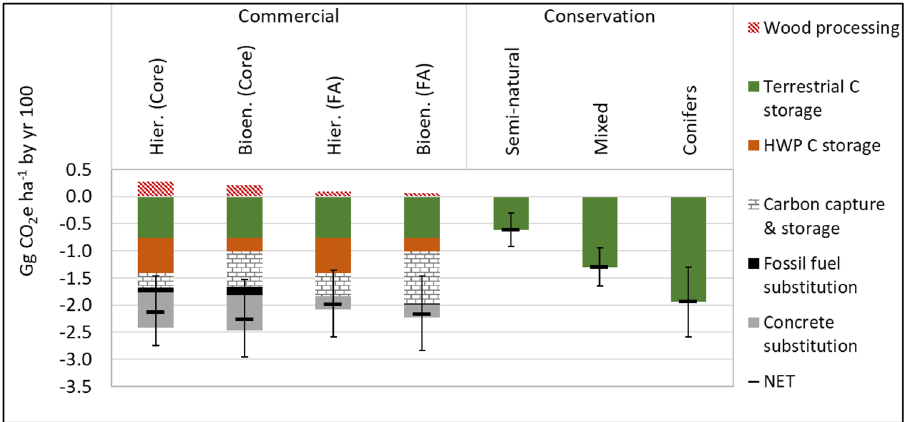
Fig. 1 Contribution of major processes to cumulative GHG fl uxes from one hectare of afforested land (planted in 2020) by year 100, for commercial and conservation forests. Default yield class 18 (m 3 ha − 1 year − 1 ) for the commercial and unharvested conifer conservation forests, 4 for the semi-natural broadleaf conservation forest and 11 for the mixed conifer-broadleaf conservation forest. Error bars represent full yield ranges presented in Table 1. Commercial forest results are presented for Core and Further Ambition (FA) decarbonisation contexts, and for Hierarchical (Hier.) and Bioenergy (Bioen.) wood use strategies, with differing mitigation contributions from concrete and fossil fuel substitution and carbon storage in harvested wood products (HWP) or long-term geological stores via carbon capture and